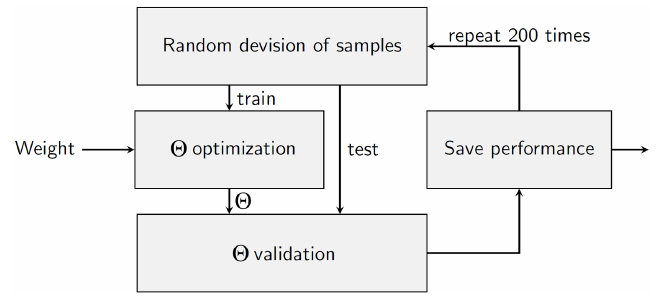
imum values and stronger incidence angle dependency (spec- ular